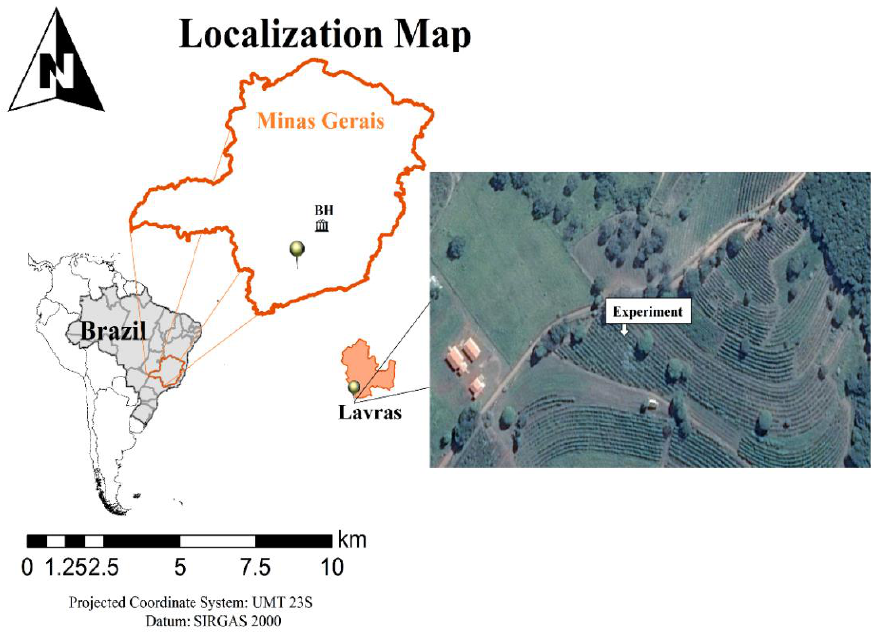
Figure 1. Location map of the experimental areas in Lavras, Minas Gerais, Brazil.